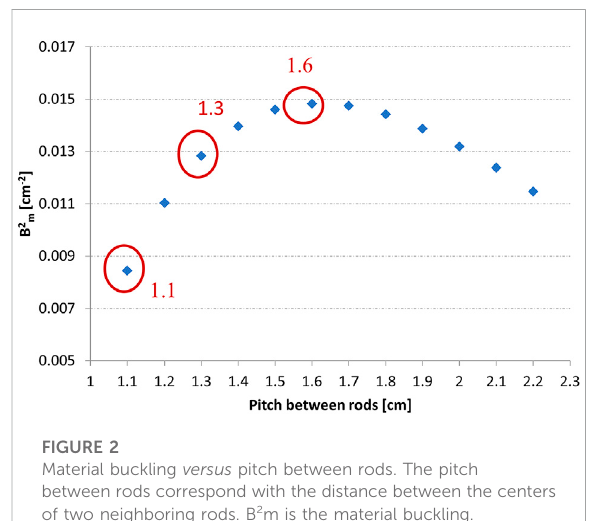
FIGURE 2 Material buckling versus pitch between rods. The pitch between rods correspond with the distance between the centers of two neighboring rods. B 2 m is the material buckling.